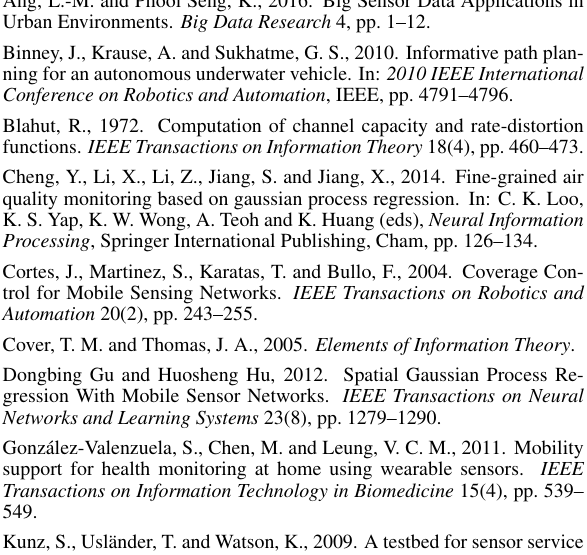
. Agents tend to explore regions where the environment is more 2Σ ∗ j